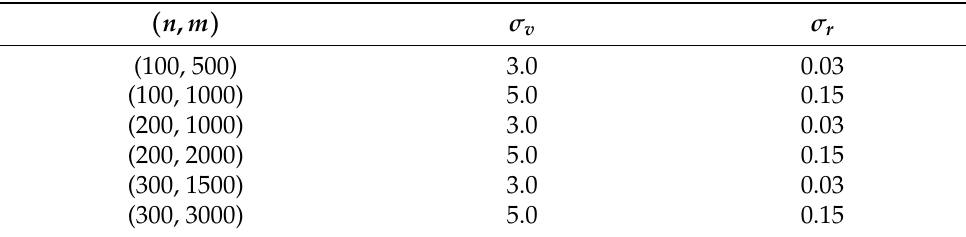
Table 1. Main parameters of the EVC and CSS instance sets of groups EVC and CSS. Each row represents a set of 30